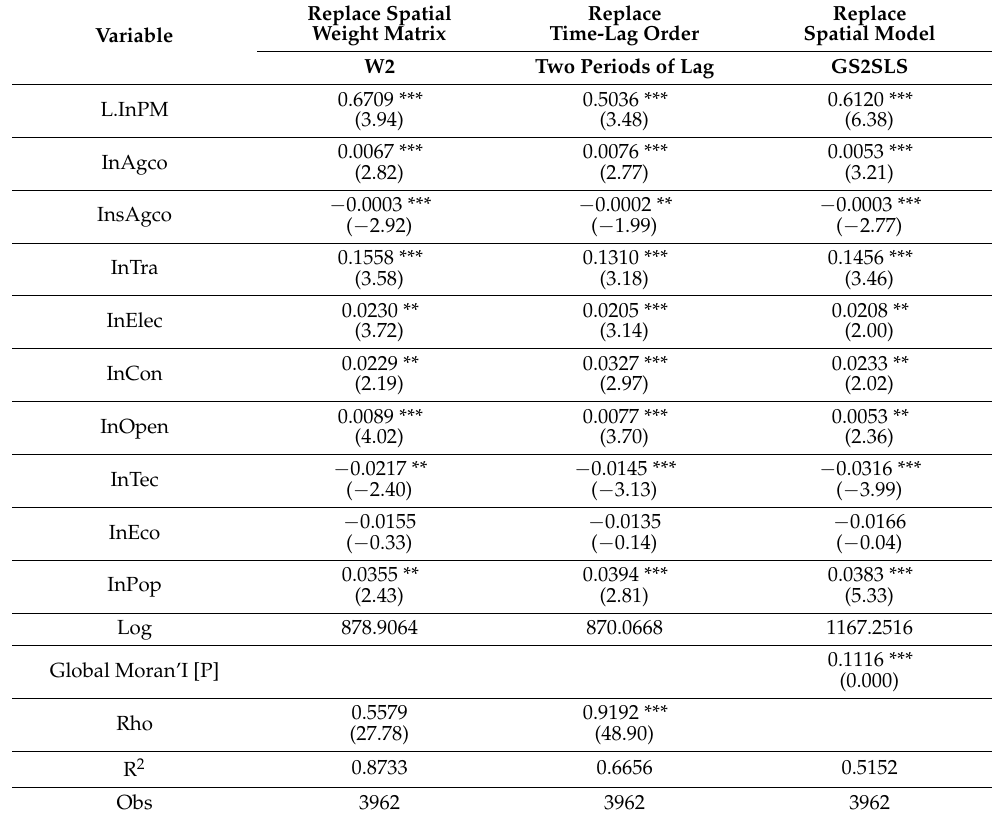
Table 4. Robustness